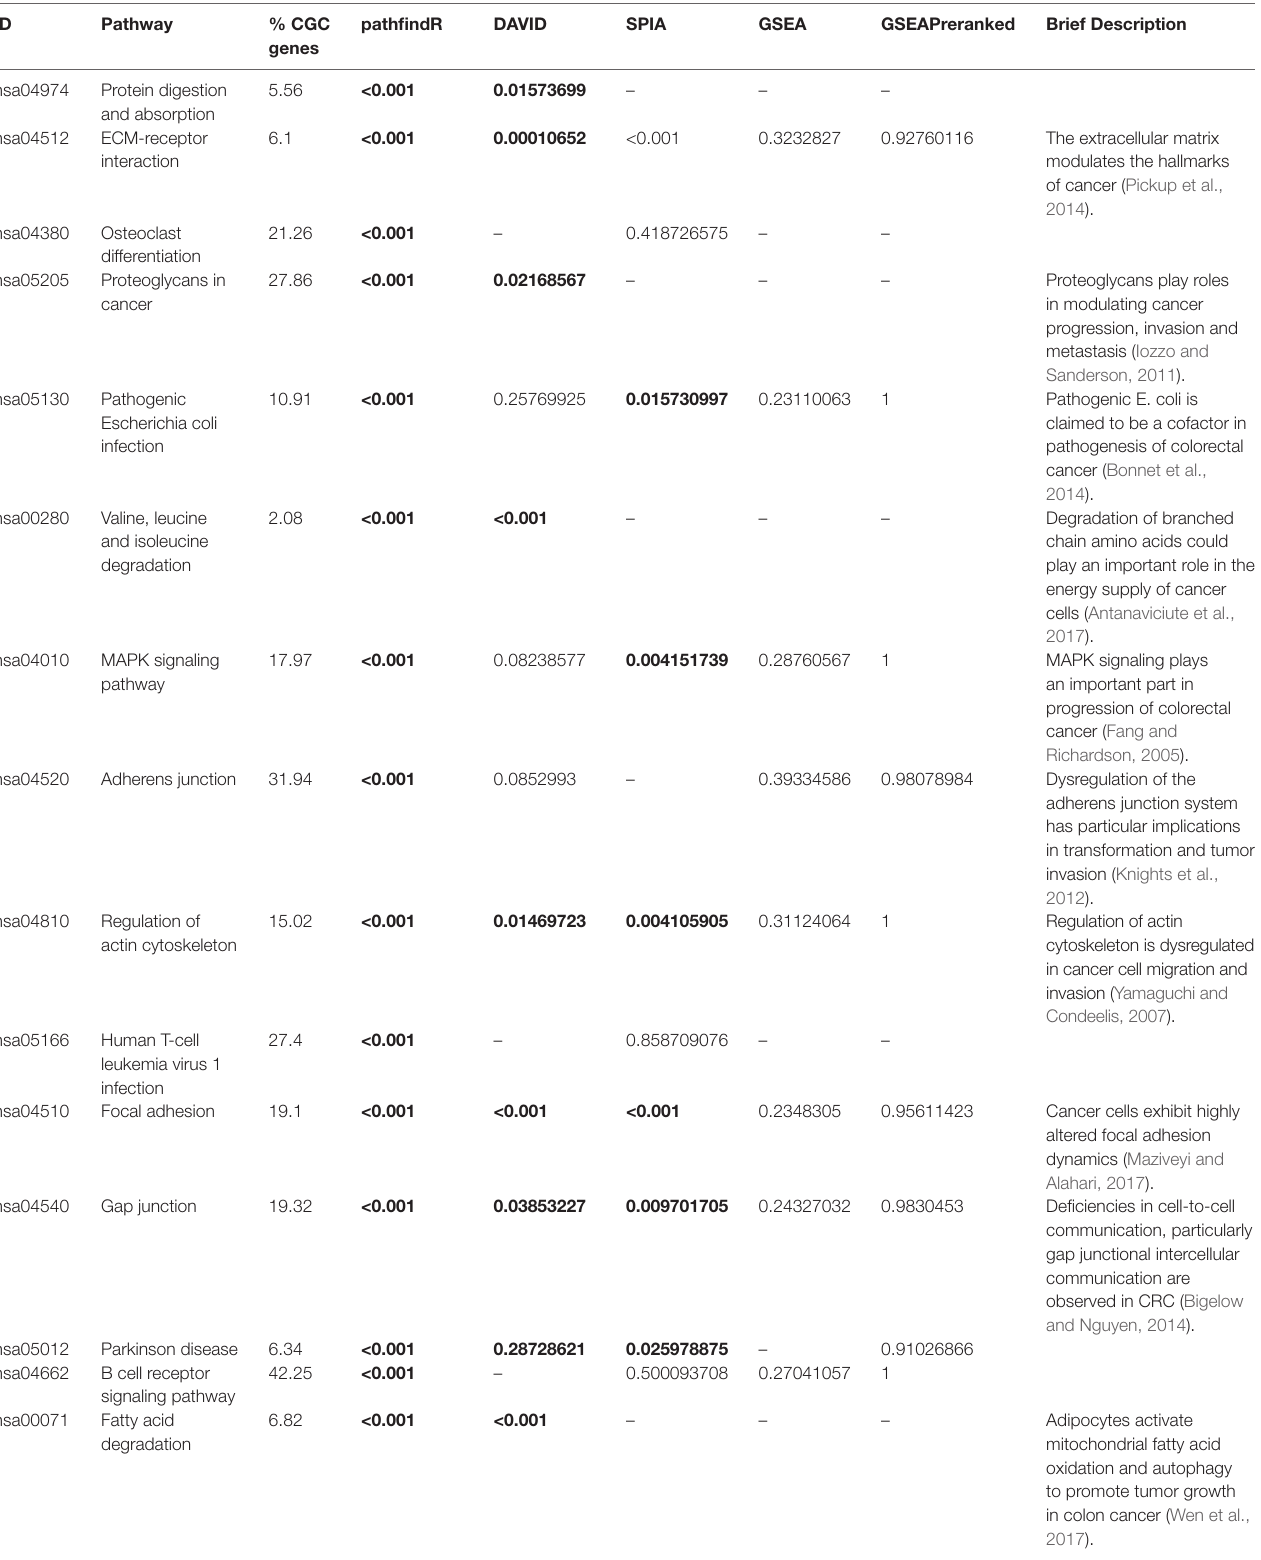
TABLE 2 | Pathway analysis results for the colorectal cancer (CRC) dataset (adjusted p <